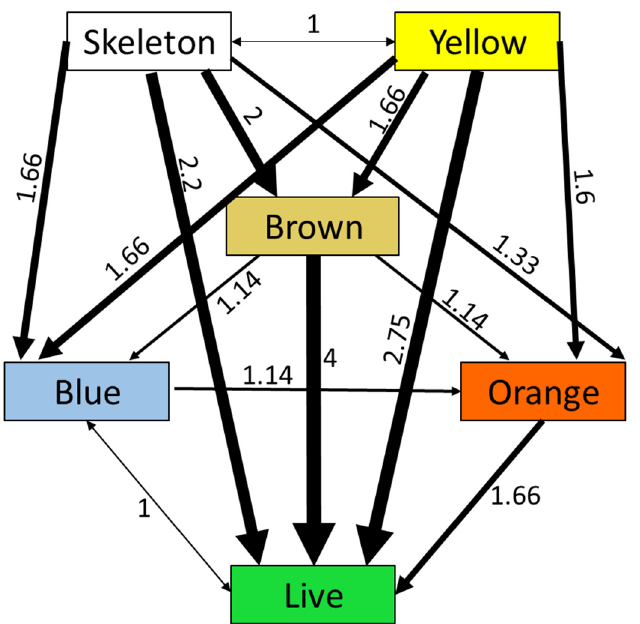
Figure 7. Hierarchal chart of fishes’ preference based on the number of fishes that preferred each model in each setting. The direction of the arrows indicates the most dominant to the less dominant models, the width of the arrows is proportional to the percentage of dominance, and the numbers next to each arrow are the ratio of more dominant to the less dominant